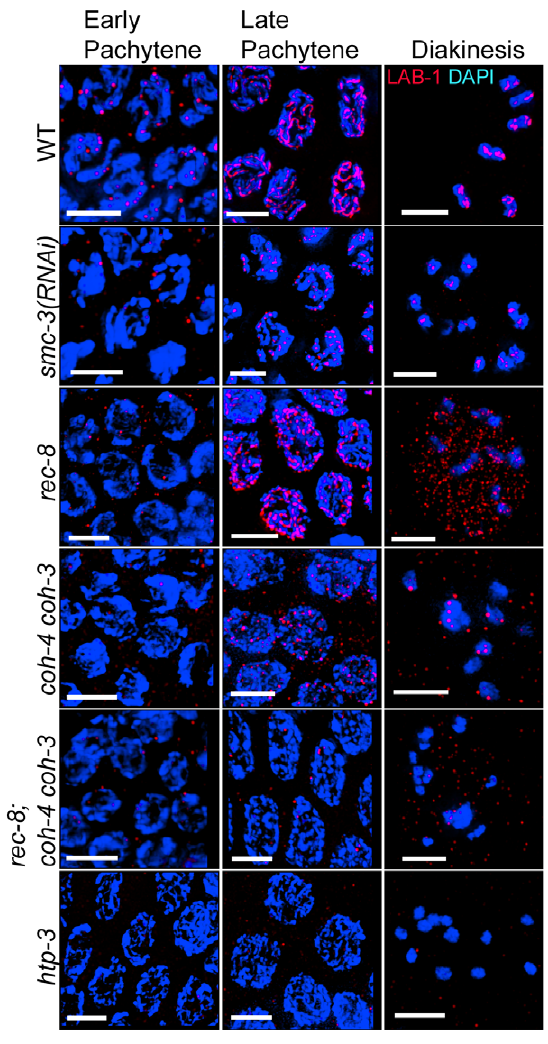
Figure 3. LAB-1 localization is dependent on the cohesin complex. LAB-1 (red) and DAPI (blue) staining of early pachytene, late pachytene, and 2 1 oocytes at diakinesis in the germlines of the indicated genotypes. Bars, 4 m M.